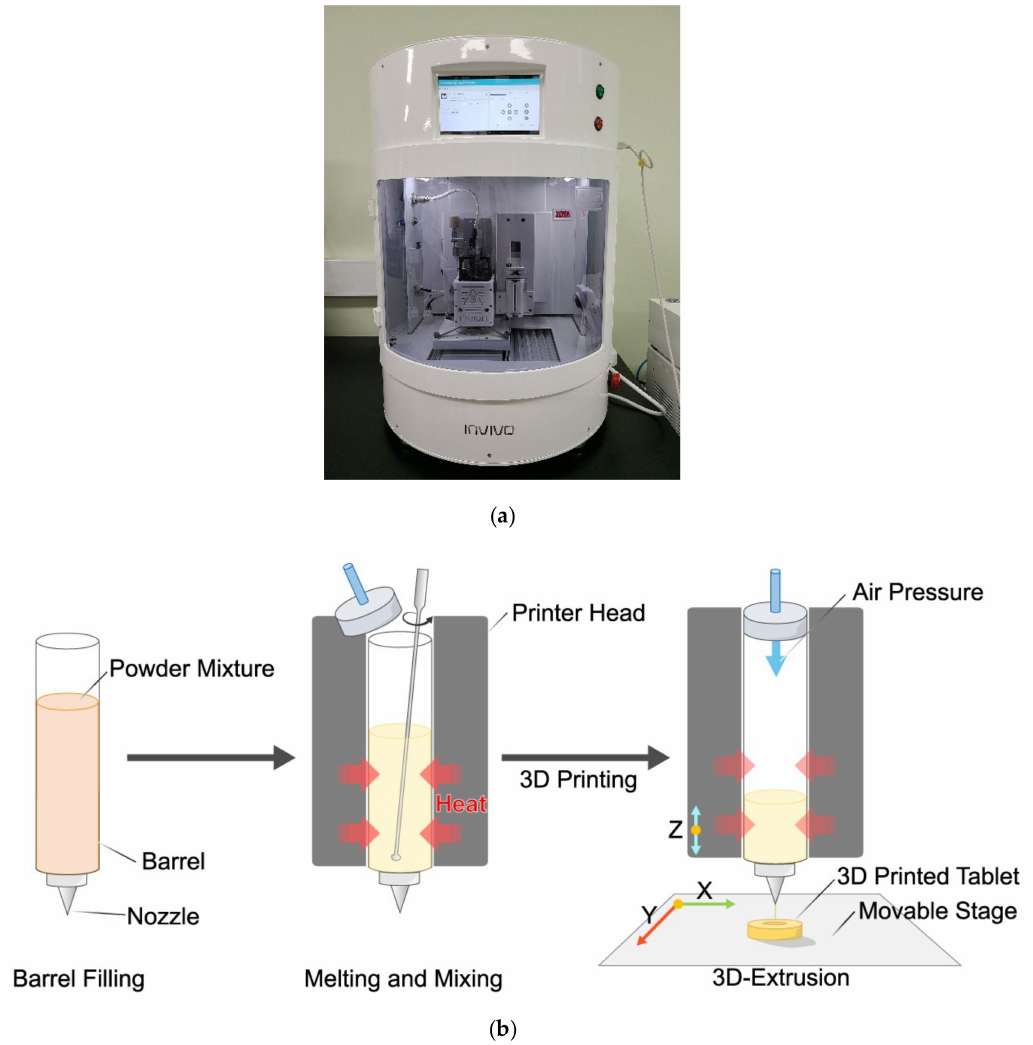
Figure 1. ( a ) ROKIT INVIVO Premium hot-melt air-extrusion 3D printer and ( b ) Schematic diagram of hot-melt 3D